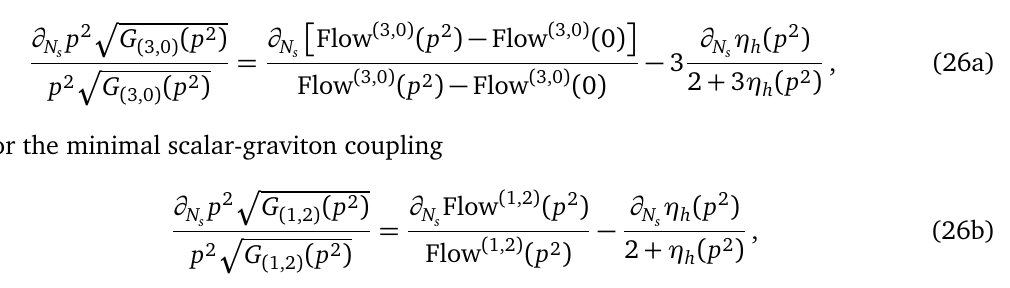
(cid:166) 10 − 10 2 . This is seen s (cid:174) 20. From there on the s